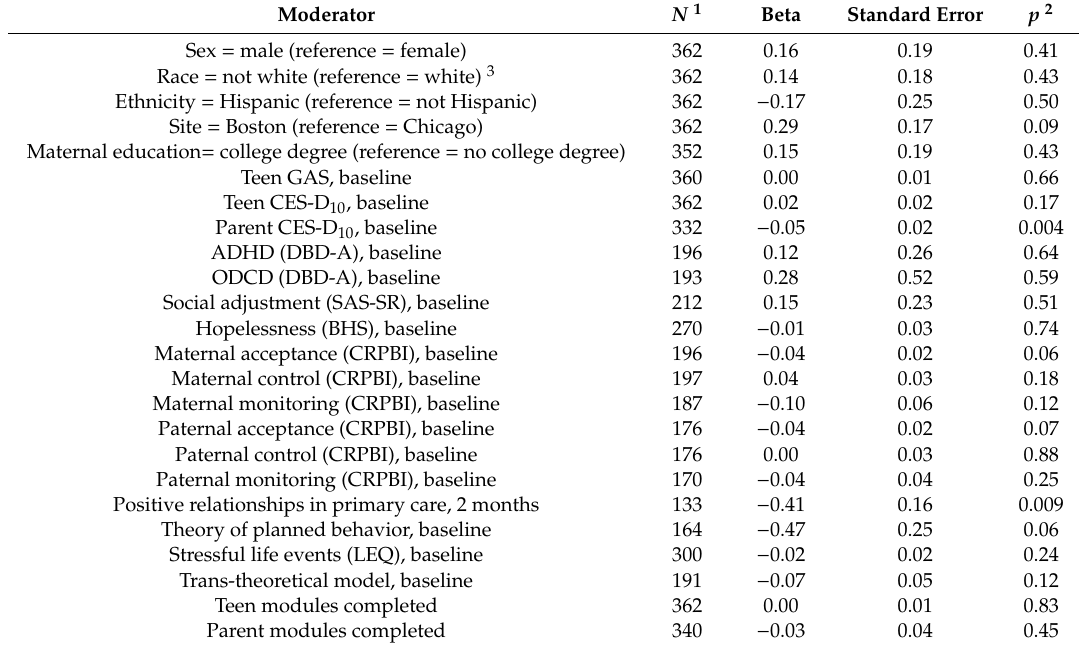
Table 2. Summary of moderator analyses for Screen for Child Anxiety Related Emotional Disorders (SCARED): Group*Visit*Moderator Interaction